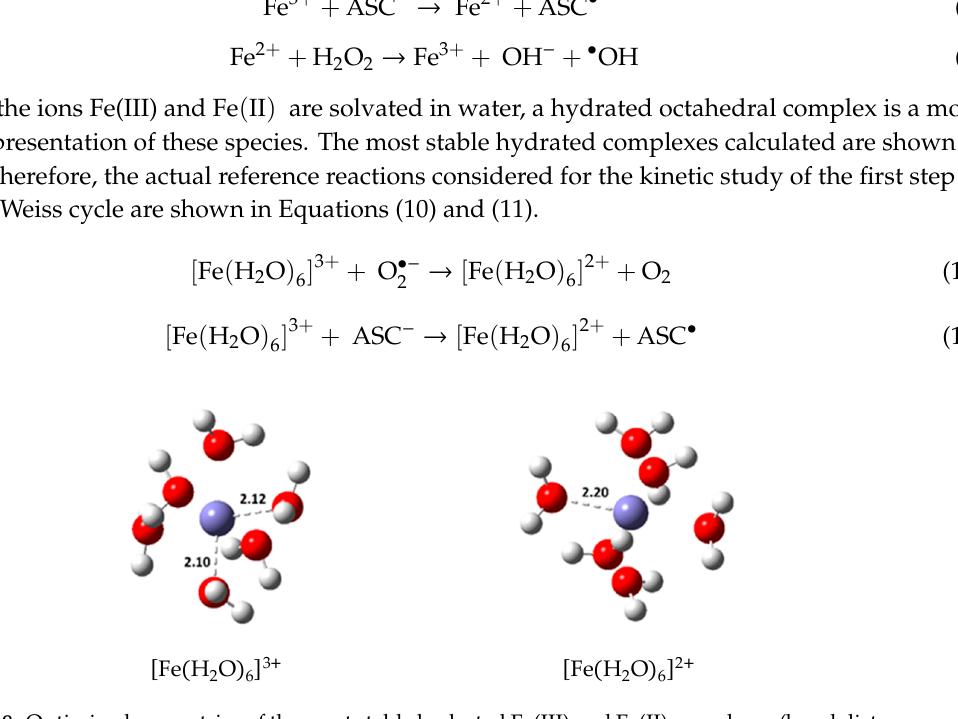
Figure 8. Optimized geometries of the most stable hydrated Fe(III) and Fe(II) complexes (bond distances in Å).